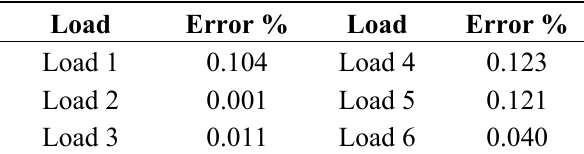
Table 6. Error estimation.